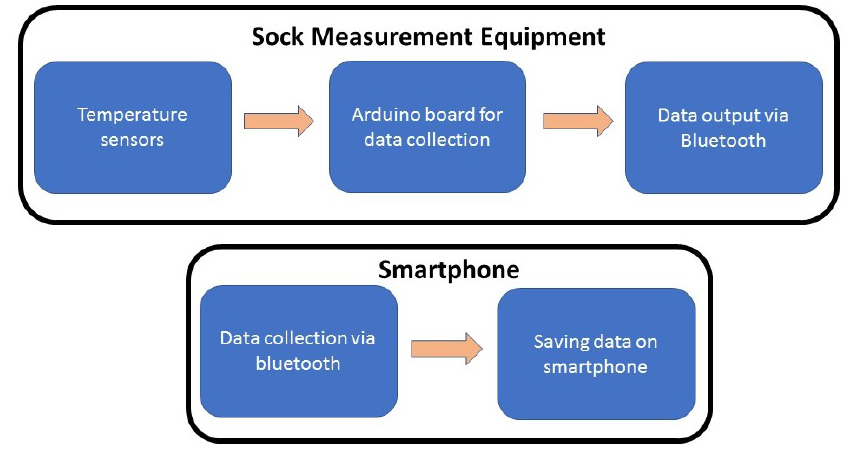
Figure 8. Block diagram of the proposed system that will be able to measure temperature, analyze it and send an alarm to the smartphone when